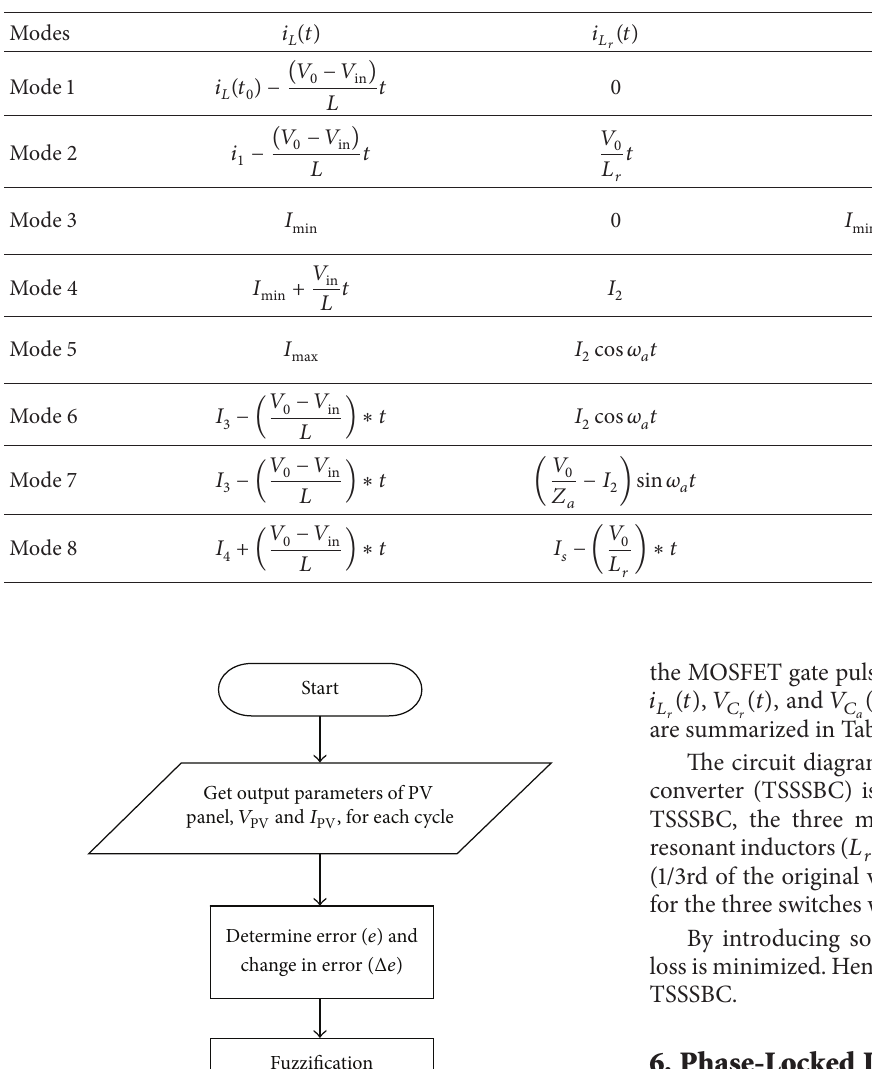
Table 2: Current and voltage equations of SSSSBC for various modes.